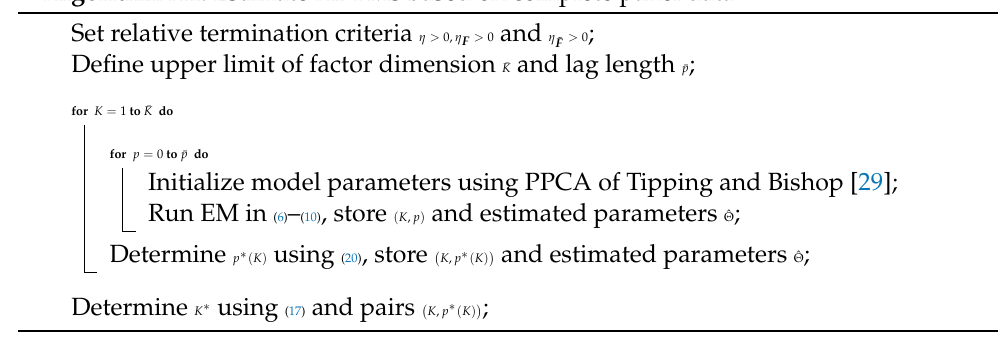
Algorithm A1: Estimate ADFMs based on complete panel data